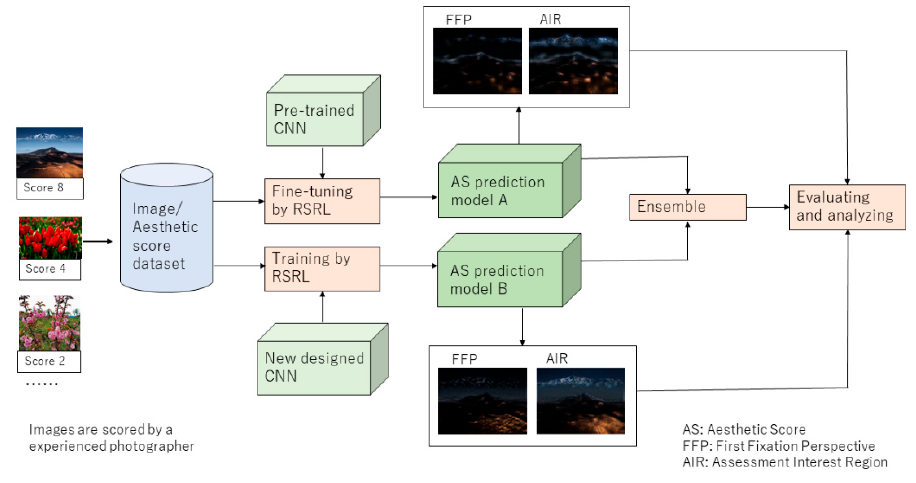
Figure 2. An overview of the proposed